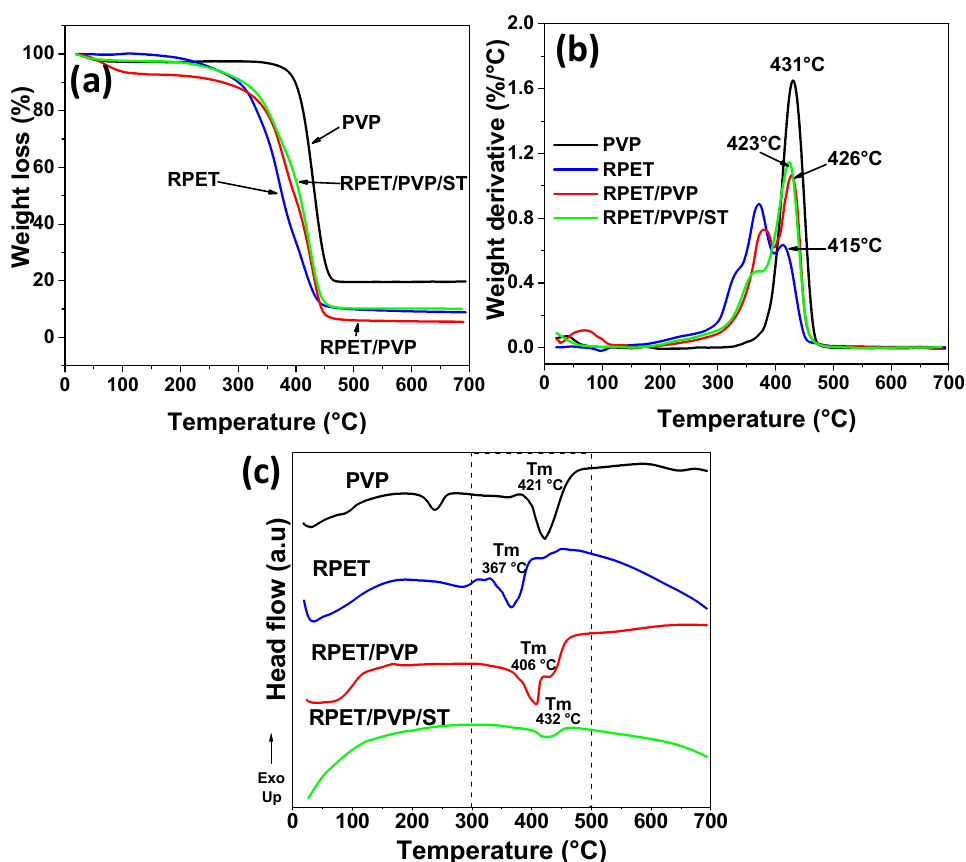
Figure 5. Thermal analysis. ( a ) TGA, ( b ) DTGA, and ( c ) DSC of the electrospun nanofibers.